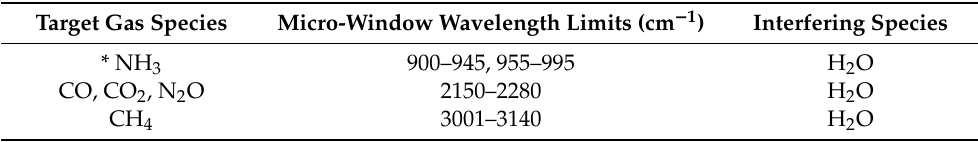
Figure 3. shows examples of the fit of the modelled synthetic spectrum to the measured spectrum and the resulting rms residual for: top left panels NH 3 in the 900 micro ‐ window and right panel in the 955 cm − 1 micro ‐ windows; lower left panel CO 2 N 2 O and CO in the 2300 cm − 1 micro ‐ window; and lower right panel CH 4 in the 3000 cm − 1 micro ‐ window. Table 2. Spectral Micro-windows limits used for the Multiple Atmospheric Layer Transmission (MALT) Table 2. Spectral Micro ‐ windows limits used for the Multiple Atmospheric Layer Transmission analysis of the OP-FTIR (MALT) analysis of the OP ‐ FTIR spectra.